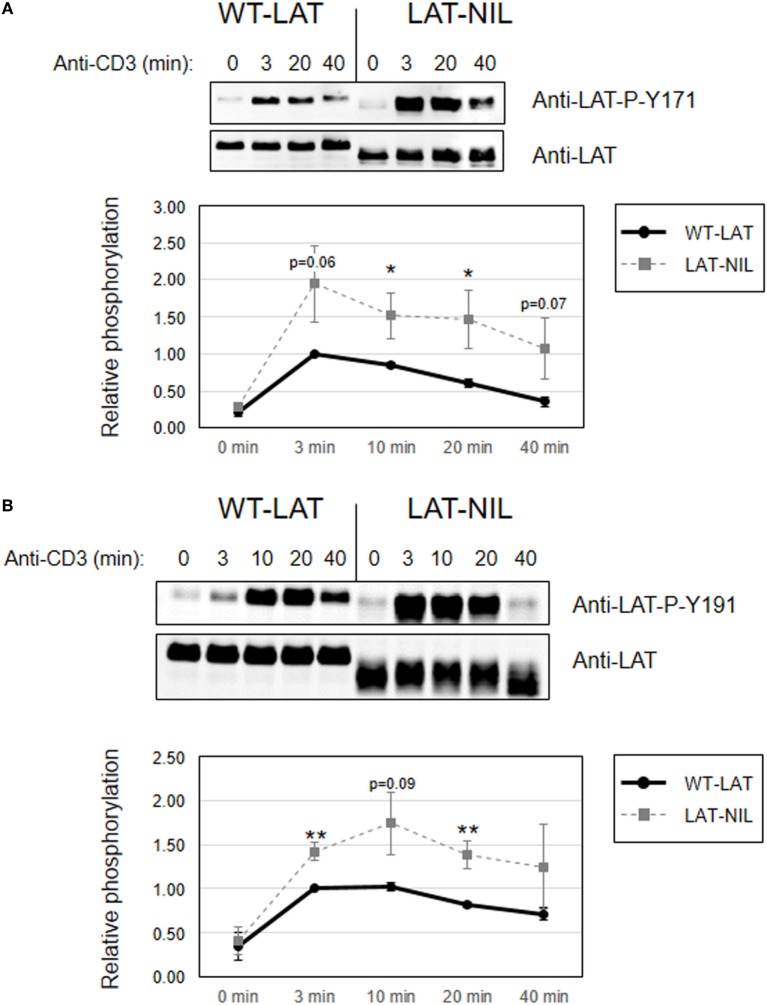
Increased phosphorylation of tyrosines 171 and 191 in linker for activation of T cell (LAT)-NIL expressing cells. Immunoblots analyzing phosphorylation of LAT at tyrosine residues 171 (A) or 191 (B) in cells stimulated with soluble anti-CD3 were done with phospho-specific antibodies. Membranes were stripped and blotted with anti-LAT antibody (middle panels). Lower diagrams represent the mean fold increase in phosphorylation in four (A) or six (B) independent experiments using J.CaM2 cells expressing WT-LAT (thick continuous line) or the LAT-NIL mutant (thin dashed line). Phosphorylation levels were normalized to total LAT expression. Bars represent the standard error. Asterisk represents statistical significance.